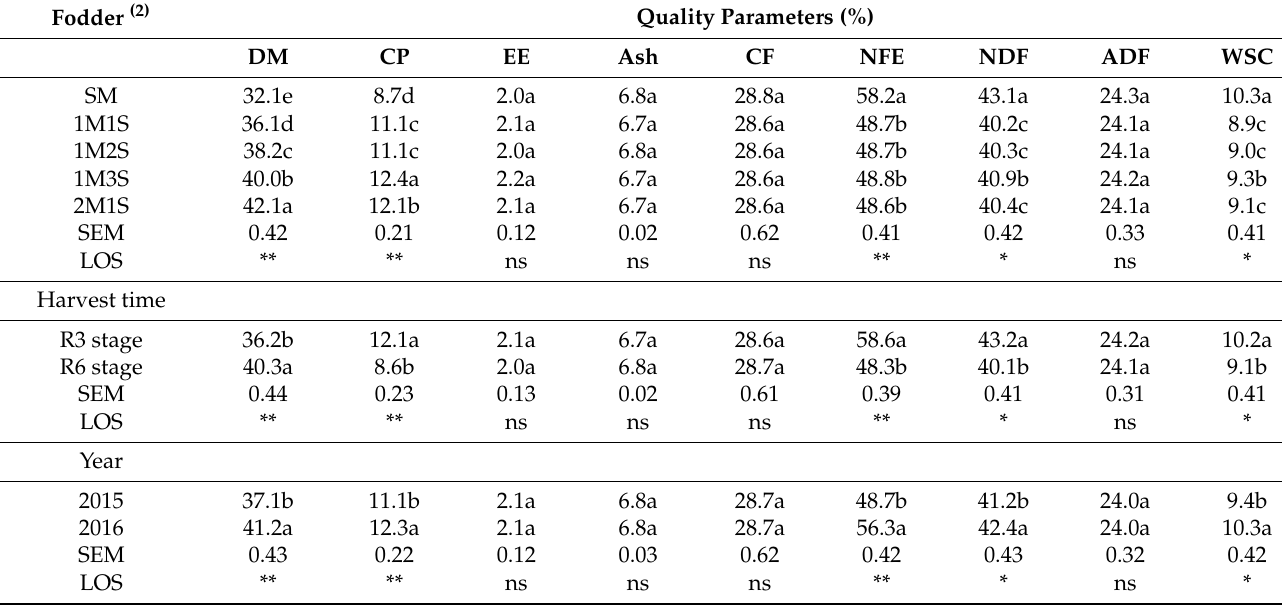
Table 2. Nutrient compositions of green fodders of maize and intercropped maize and soybean at two maturity stages (% DM) (1).